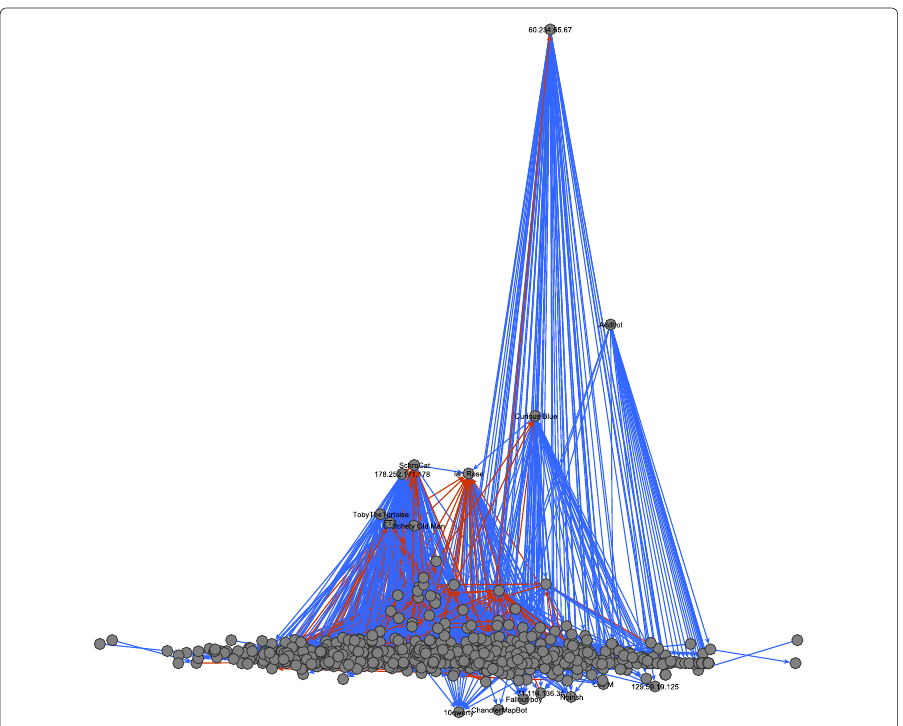
Fig. 7 Hierarchy derived from dyadic interaction among editors of the Wikipedia article “The Third Man.” The y -coordinate of node A is proportional to the value hierarchy . dyadic ( A ) . Dominance edges pointing in the wrong direction (i.e., from lower to higher) are